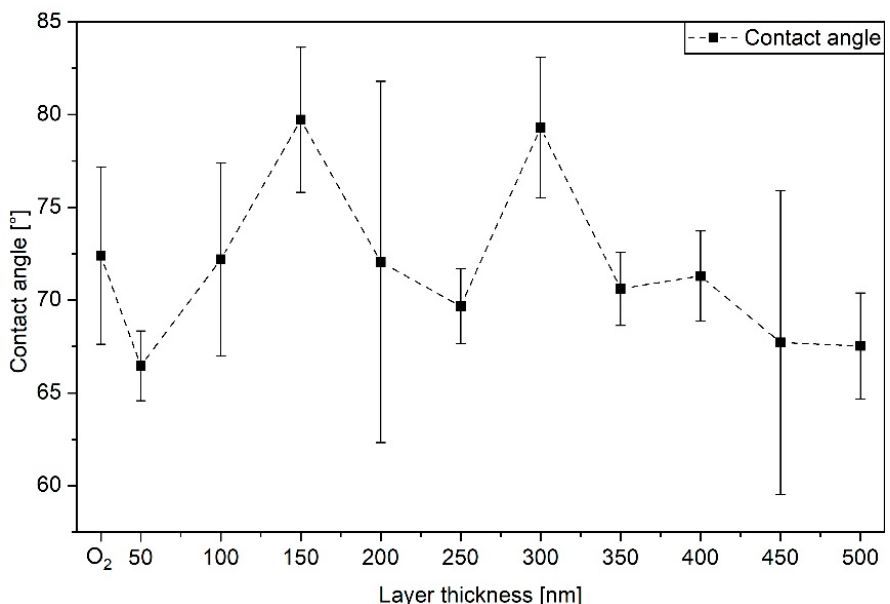
Figure 2. Contact angles of amorphous hydrogenated carbon (a-C:H) coatings of various thickness on previously O 2 plasma treated PHB samples (see first point). The dashed line is included to enhance visibility.